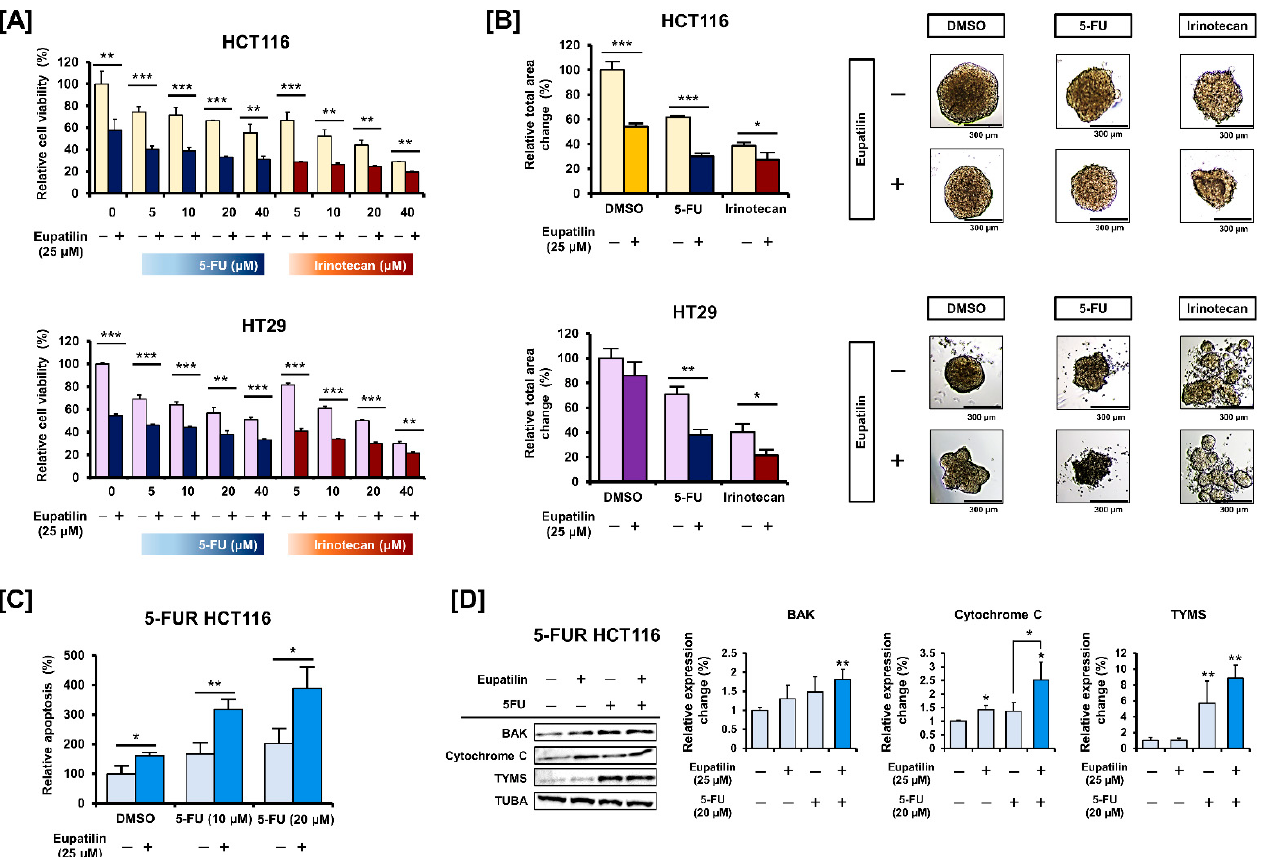
Figure 7. Synergistic effect of eupatilin combined with standard anticancer drugs. ( A ) Effects of eupatilin combined with 5-FU or irinotecan on HCT116 and HT29 cell viability. ( B ) Bright field images showing the changes in spheroid morphology following eupatilin treatment combined with 5-FU or irinotecan. The total area and density of the spheroid were calculated using the ImageJ software. ( C ) Flow cytometric detection of apoptosis in 5-FUR HCT116 cells in response to 5-FU and eupatilin combined treatment using Annexin V and PI staining. ( D ) BAK, cytochrome c, and TYMS expression levels in response to eupatilin and 5-FU combined treatment for 24 h in 5FUR HCT116 cells. Asterisks indicate a significant change after eupatilin treatment (*** p < 0.001, ** p < 0.01, and * p < 0.05).